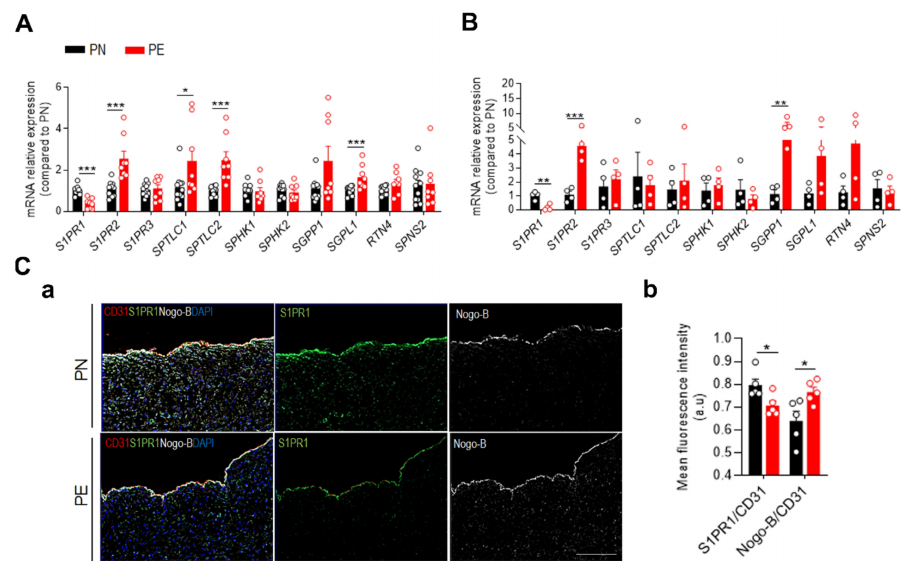
Figure 2. PE alters S1P signaling. RT-PCR of PN ( n = 10) and PE ( n = 8) homogenates of chorionic arteries ( A ) and isolated fPAEs (PN n = 4; PE n = 4) ( B ). Representative immunofluorescence staining of CD31, S1PR1 and Nogo-B in placental chorionic arteries of PN ( n = 5) and PE ( n = 5) subjects. Scale bar: 100 µ m ( C , a ). Scatter plot of fluorescence intensity quantified by using ImageJ. Mean fluorescence intensity was calculated as the ratio of S1PR1 / CD31 and Nogo-B / CD31. CD31 was used as the reference marker for the endothelium ( C , b ). Data are expressed as mean ± SEM * P < 0.05; ** P < 0.01; *** P < 0.001 compared to PN. Statistical significance was determined by unpaired t